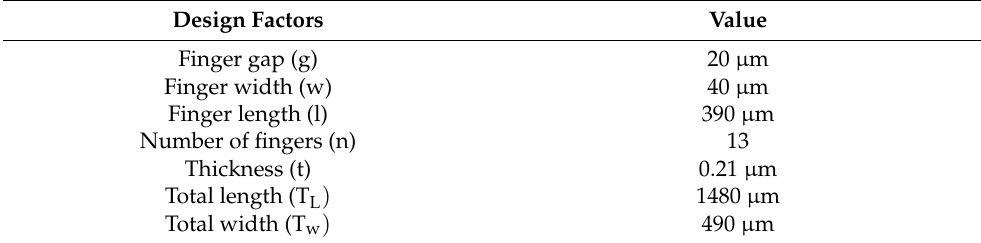
Figure 5. Simplified view of interdigitated electrodes with defined design factors. Table 1. Design factors of the IDEs.